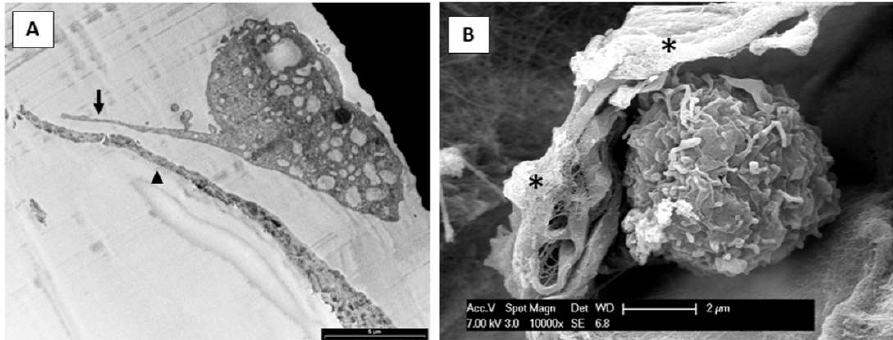
Figure 4. Photomicrographs acquired by TEM ( panel A ) and SEM ( panel B ) showing hASCs grown in FWM. In panel A, the arrow indicates the pseudopod-like structures while the arrowhead indicates the scaffold. In panel B a cell, covered by some collagen fibrils, appears to have colonized the scaffold. The asterisk indicates the scaffold. Scale bare in panel A is 5 μm.